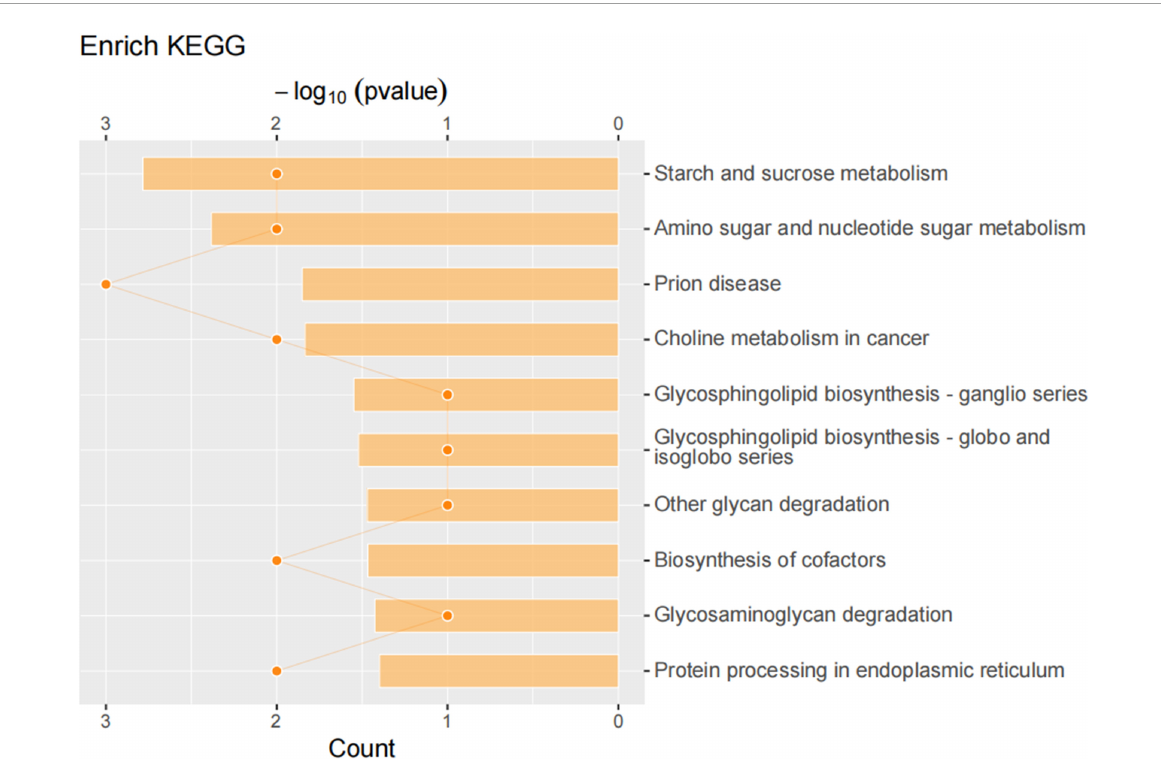
FIGURE8 Kyoto Encyclopedia of Genes and Genomes (KEGG) pathway analysis of differentially expressed proteins. KEGG pathway annotation was performed on the selected differentially expressed proteins to analyze and determine the most important metabolic and signal transduction pathways involved in the differentially expressed